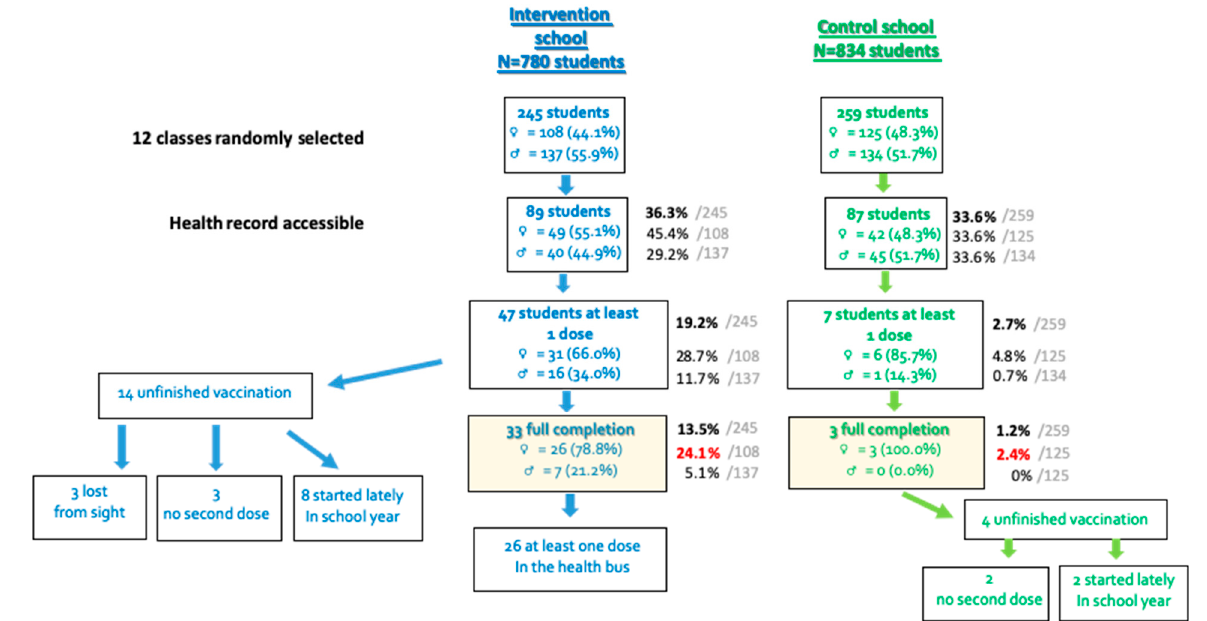
Figure 1. Flow chart. ♀ : girls, ♂ : boys. Table 1. Characteristics of children for whom health records were accessible. Table 1. Characteristics of children for whom health records were